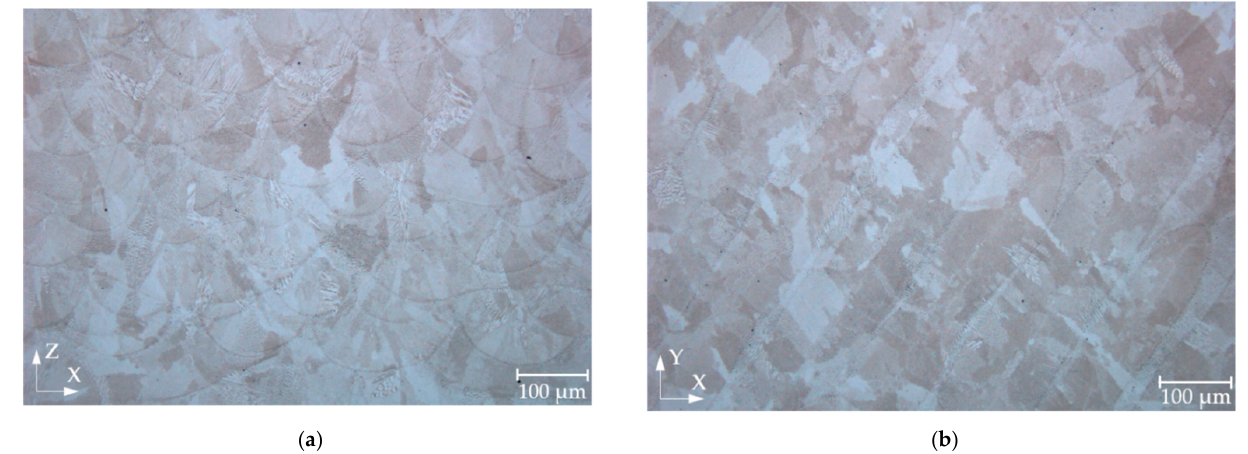
Figure 4. Light microscopy images of LPBF processed specimens fabricated using base plate preheating at 400 °C. ( a ) XZ plane. ( b ) XY plane.